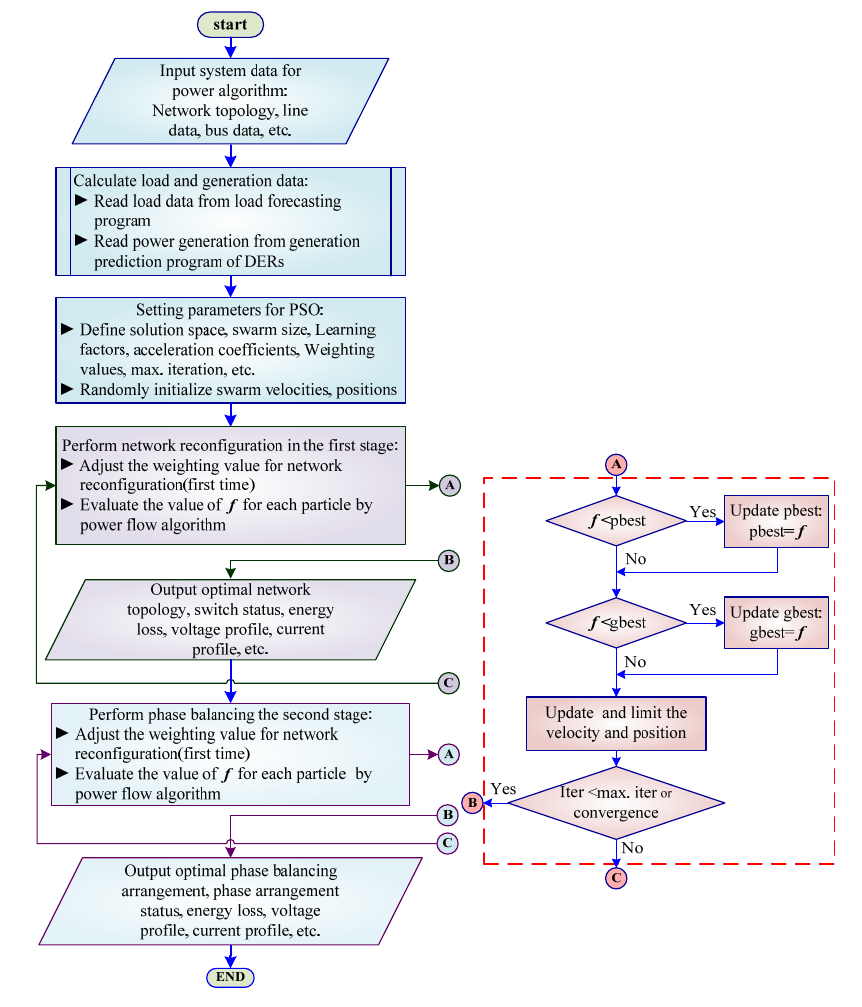
Figure 3. The flow chart of the solution